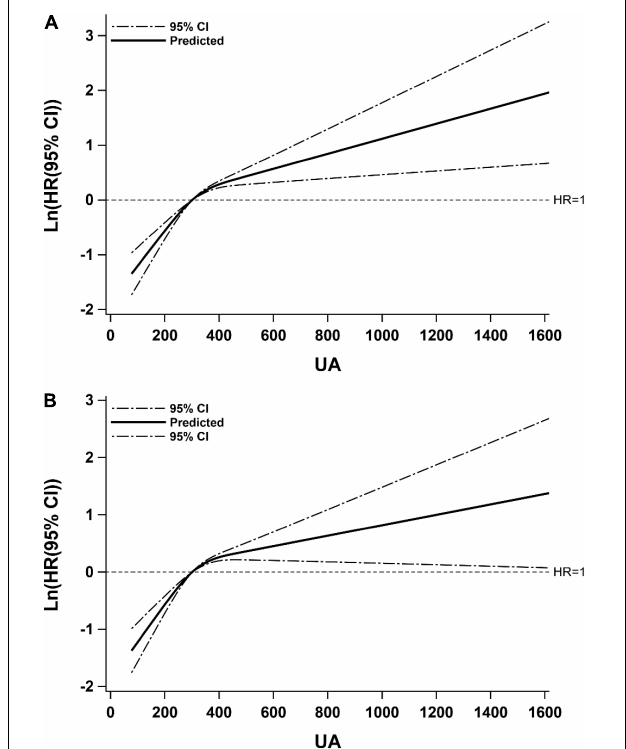
FIGURE 2 | Restricted cubic spline for associations of UA with ischemic stroke recurrence. Model (A) adjusted for age, gender, hypertension, diabetes, atrial fibrillation, coronary heart disease, HCY, carotid atherosclerosis, TOAST; Model (B) adjusted for covariates from Model A and further adjusted for NLR. Hazard ratios were indicated by solid lines and 95% CIs by dotted lines. CI, confidence interval; HR, hazard ratio; UA, uric acid.